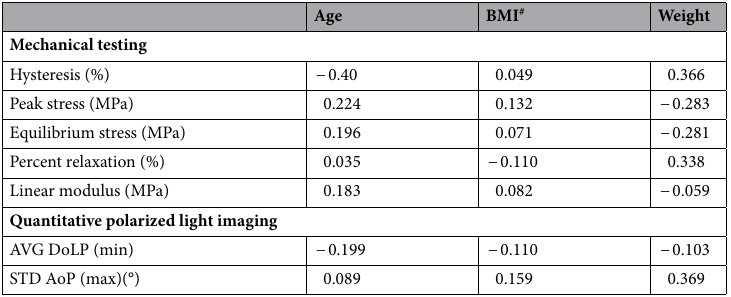
Table 1. Correlation matrix for primary variables of interest and participant demographics. No relationships were statistically significant ( p < 0.05); Values are Pearson correlation coefficient unless otherwise noted, # Indicates Spearman’s rho; average degree of linear polarization (AVG DoLP), standard deviation angle of polarization (STD AoP), minimum (min), maximum (max)